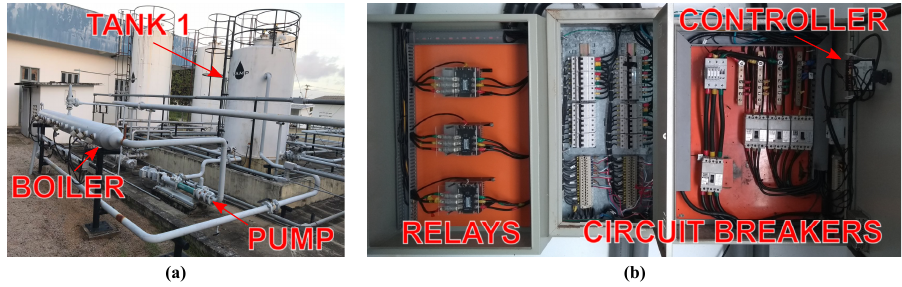
Figure 6. Water heating system. ( a ) Heating plant: boiler, pump, and tank. ( b ) Heating electrical